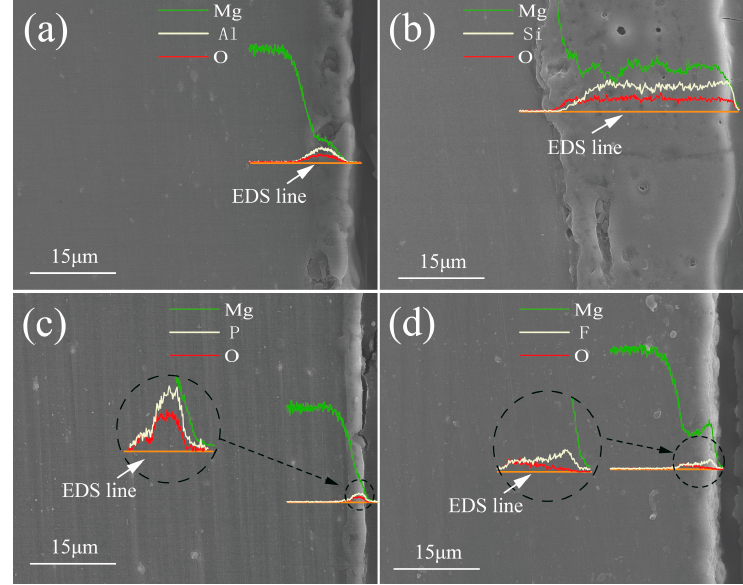
Figure 6. Elements linear scanning analysis of the PEO coatings. ( a ) Al-coating, ( b ) Si-coating, ( c ) P- coating, ( d ) F-coating. P-coating, ( d )